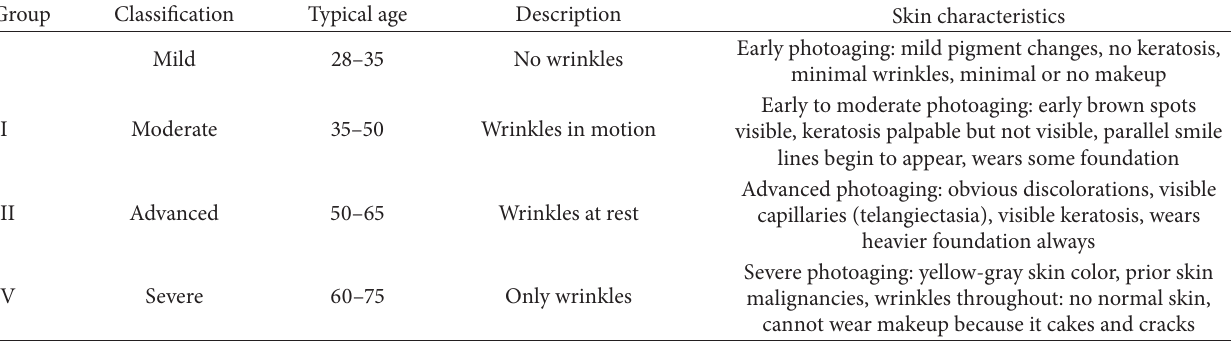
Table 1: Glogau classification of photoaging.